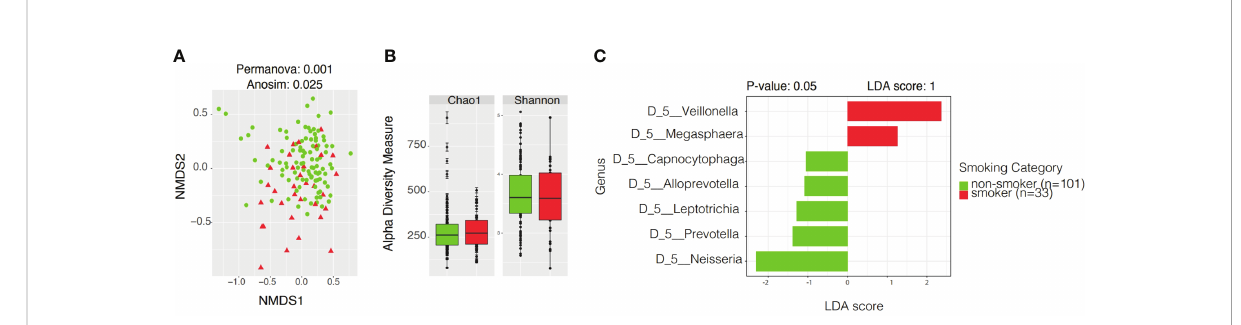
FIGURE 7 Community pro fi les including beta, alpha diversity, taxonomic pro fi les of bacterial diversity analysis and linear discriminant analysis Effect Size (LEfSe) according to smoking status. (A) Beta diversity analyses by Non-metric Multidimensional Scaling (NMDS) contrasting community